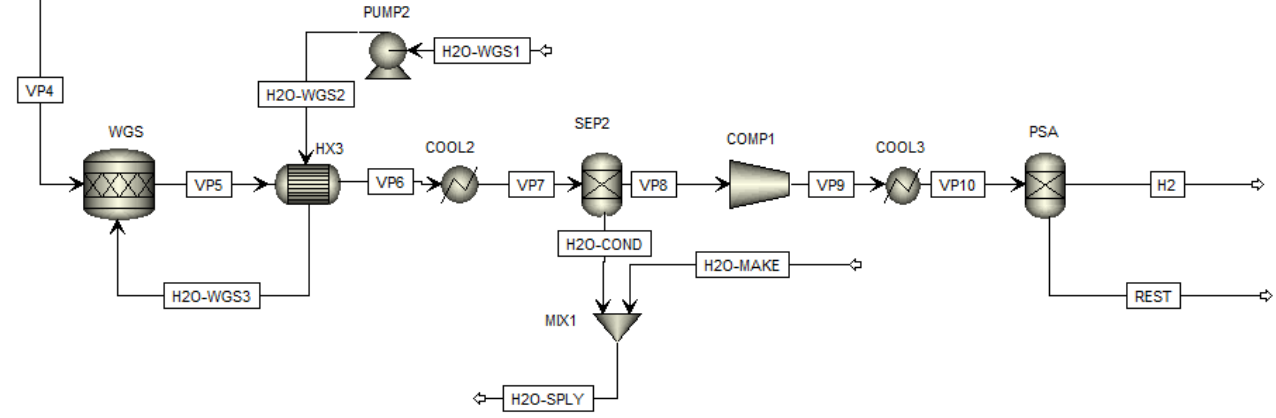
Figure 5. Flowsheet diagram of the WGS and PSA processes.